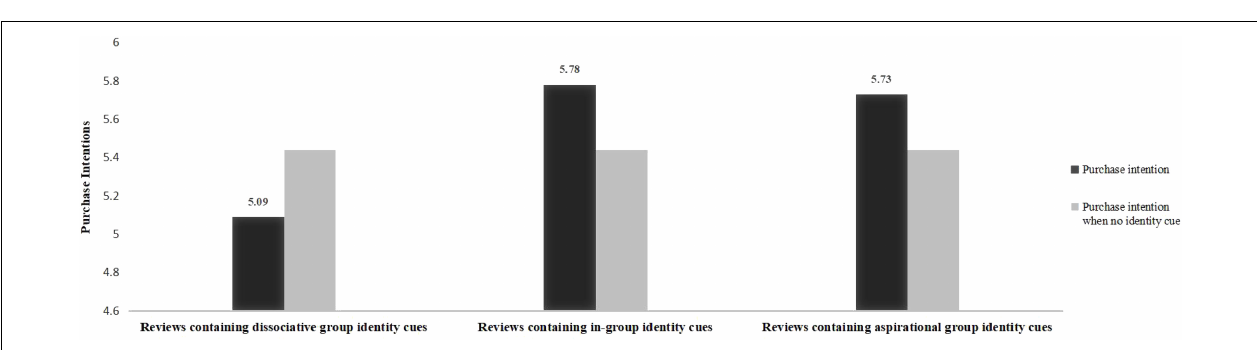
FIGURE 3 | Comparison of purchase intentions after reading product